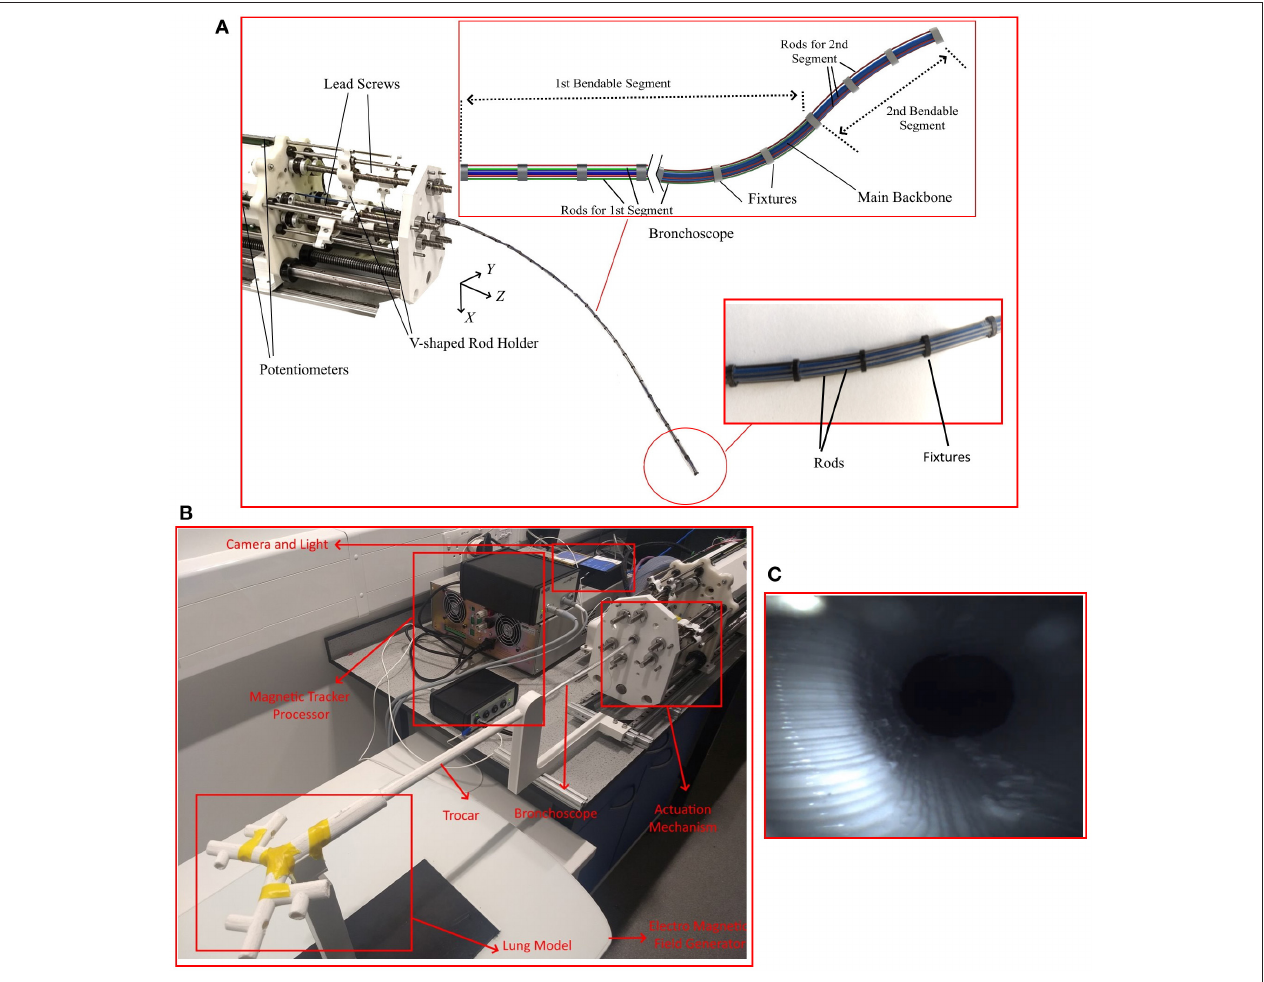
FIGURE 2 | The robotic bronchoscope. (A) The inlet shows the tip of the bronchoscope which is composed of two segments that can be independently bent. By pulling/pushing the wires at each segment the bronchoscope can bend in 3D space. (B) The bronchoscope prototype placed inside a 3D printed lung model. An electromagnetic tracker (Aurora electromagnetic tracking system, NDI, Canada) is placed at the tip of the bronchoscope to measure its tip position in real-time. (C) Camera view from the endoscopic camera placed inside the working channel of the bronchoscope.